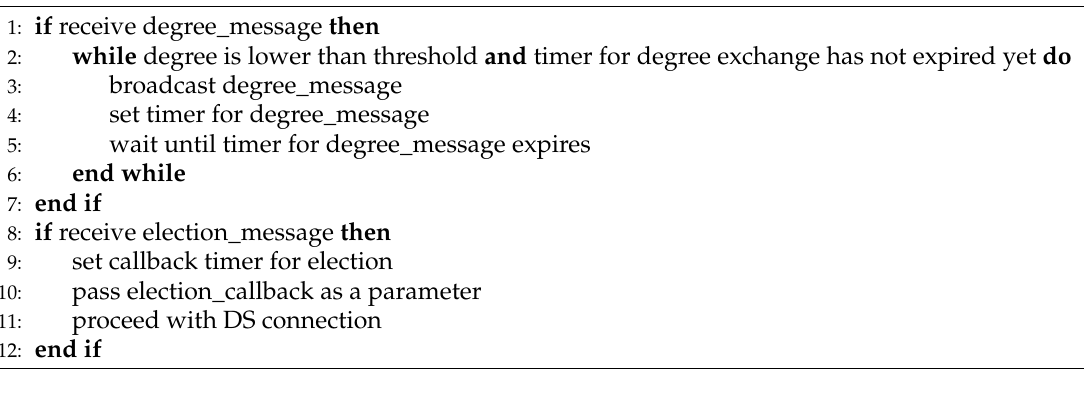
Algorithm 4 Dominating set